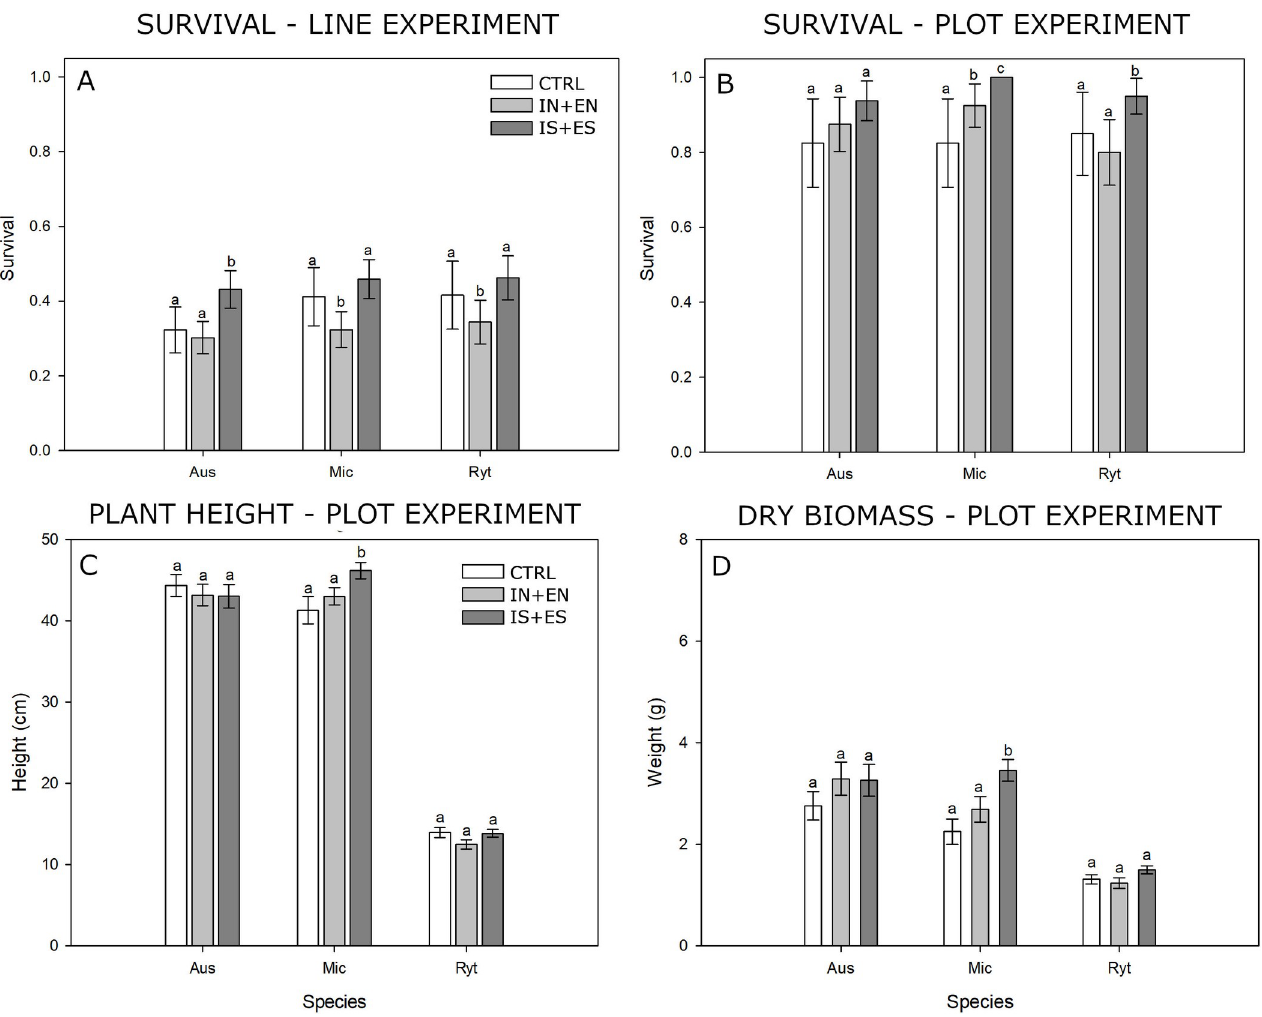
Fig 5. Survival and plant growth. Survival and plant growth comparison 40 weeks after sowing, between untreated seeds (CTRL), seed treated without salicylic acid (IN+EN) and seed treated with salicylic acid (IS+ES). Average plant survival in (A) line experiment with seeds sown alongside a 1 m line and in (B) plot experiment, where intraspecific competition was limited, by removing excess seedlings and leaving 10, evenly spaced seedlings per 0.25 m 2 plot. (C) Average height and (D) biomass of plant collected from the plot experiment. Results followed by the same letter are not statistically different at p < 0.05.